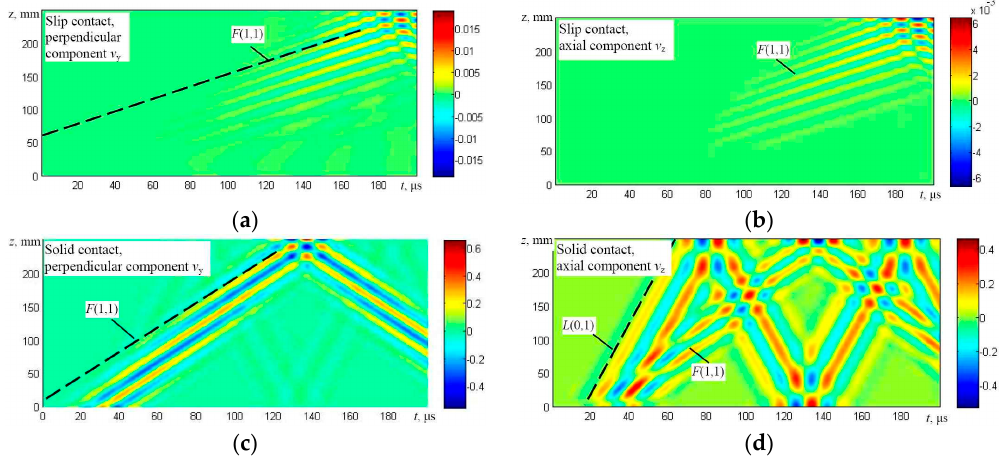
Figure 8. The B-scan images of the particle velocity along the second line of monitoring (the lower surface of the fifth wire) in the case of the edge type excitation: particle velocity components v y perpendicular to the axis of the wire ( a ) and v z (longitudinal-axial) ( b ) in the case of a slip contact and particle velocity components v y perpendicular to the axis of the wire ( c ) and v z (longitudinal-axial) ( d ) in the case of a solid contact between the neighboring wires.